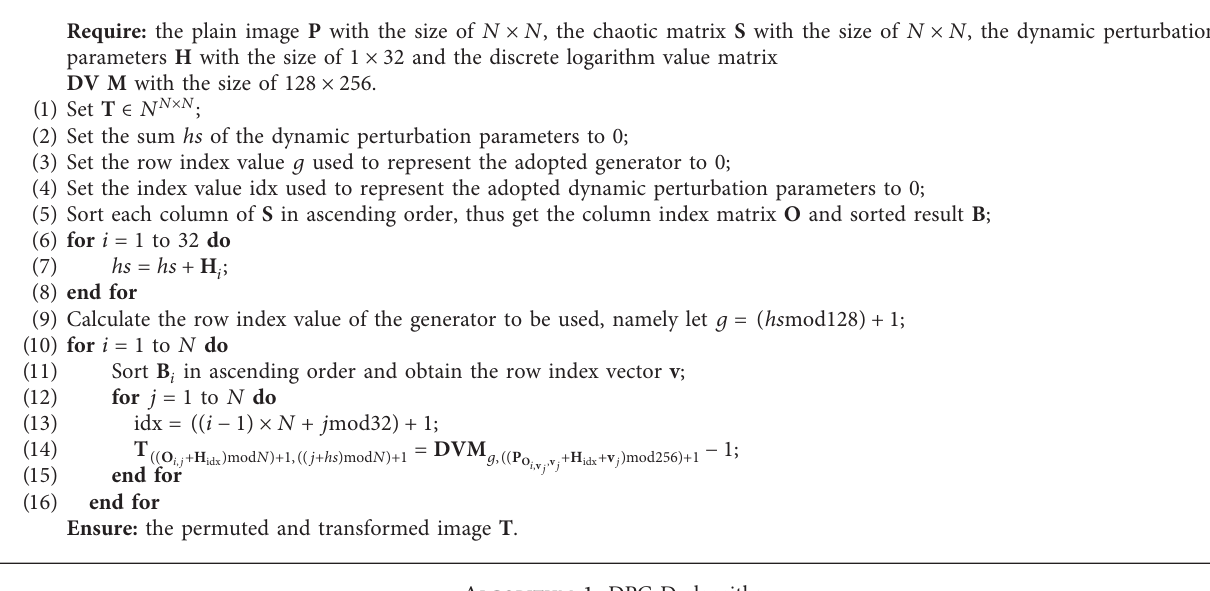
A LGORITHM 1: DPC-D algorithm.